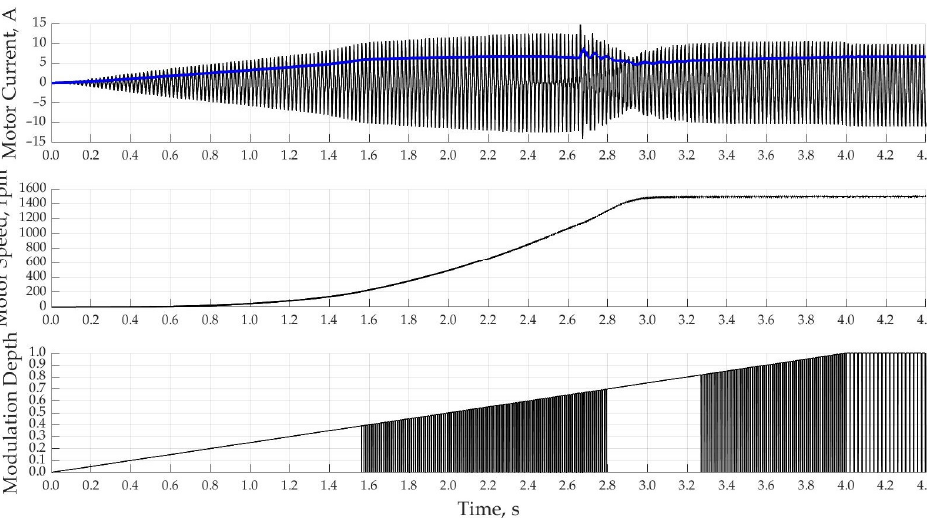
Figure 11. Starting current, motor speed and modulation depth under relay controller with all zones disabled.